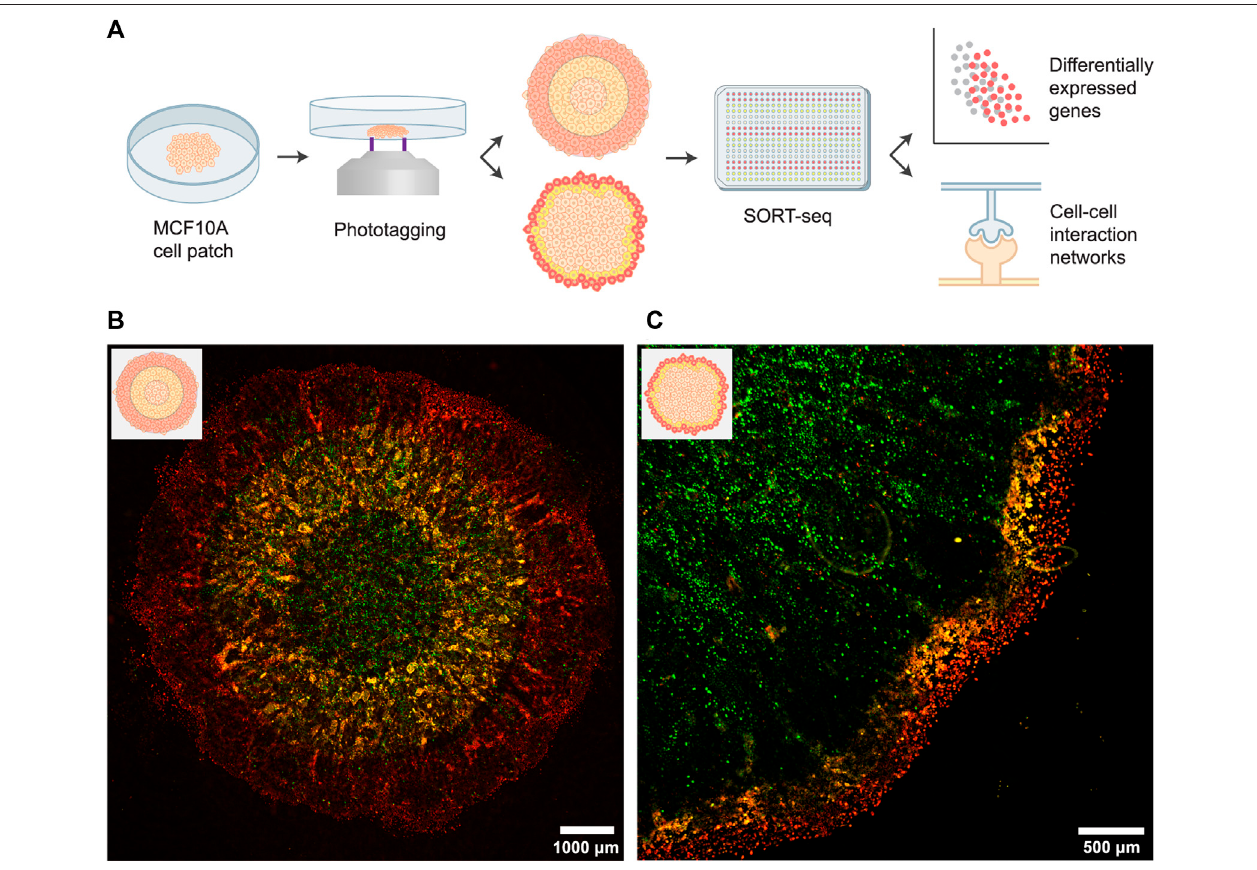
FIGURE1| Spatiallypro fi lingan invitro tumormodelusingtheFUNseqtechnology. (A) Schematicdepictionoftheassay,celllabelingandscRNA-seqanalysis.For the cell labeling (middle panel), we either phototagged concentric rings of equal width (top; 1,000 – 1,500 μ m bandwidth) or 250 μ m wide bands at the invasive edge (bottom). In both approaches, the outer population was labeled with JF646 phototagging dye (red) and the middle population was labeled with both JF549 and JF646 (yellow). (B) Patch of MCF10A cells expressing a GFP marker that was phototagged with the larger bandwidth. Green: GFP, yellow: JF549, red: JF646. (C) Phototagging the invasive edge of a MCF10A cell patch yields well-demarcated bands of